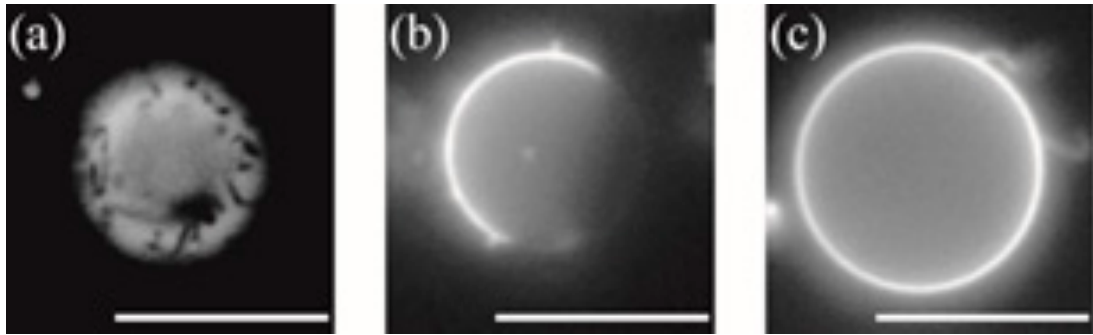
Figure 3. Typical fluorescence microscopic images of S o domain in DOPC/DPPC (50/50) ( a ), L o domain in DOPC/DPPC/Chol (40/40/20) ( b ), and no domain (homogeneous phase) in DOPC/DPPC/Chol (35/35/30) ( c ). Scale bar = 10 μ m.